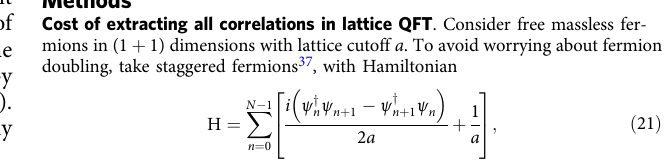
Fig. 3 Asymptotic-case entanglement temperature for two critical spin models. T A Heisenberg anti-ferromagnet ( a ) and the critical transverse- fi eld Ising model ( b ), for multiple system sizes. Notice that near the ground state T A which we prove is generic in the Methods section. The one-shot entanglement temperature T ent is lower bounded by the asymptotic temperature T A